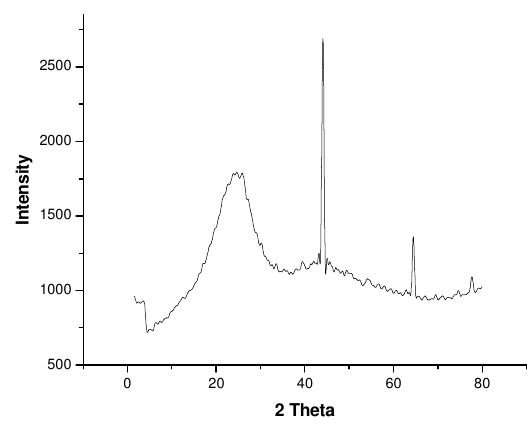
Figure 2 . X-ray Diffraction pattern for